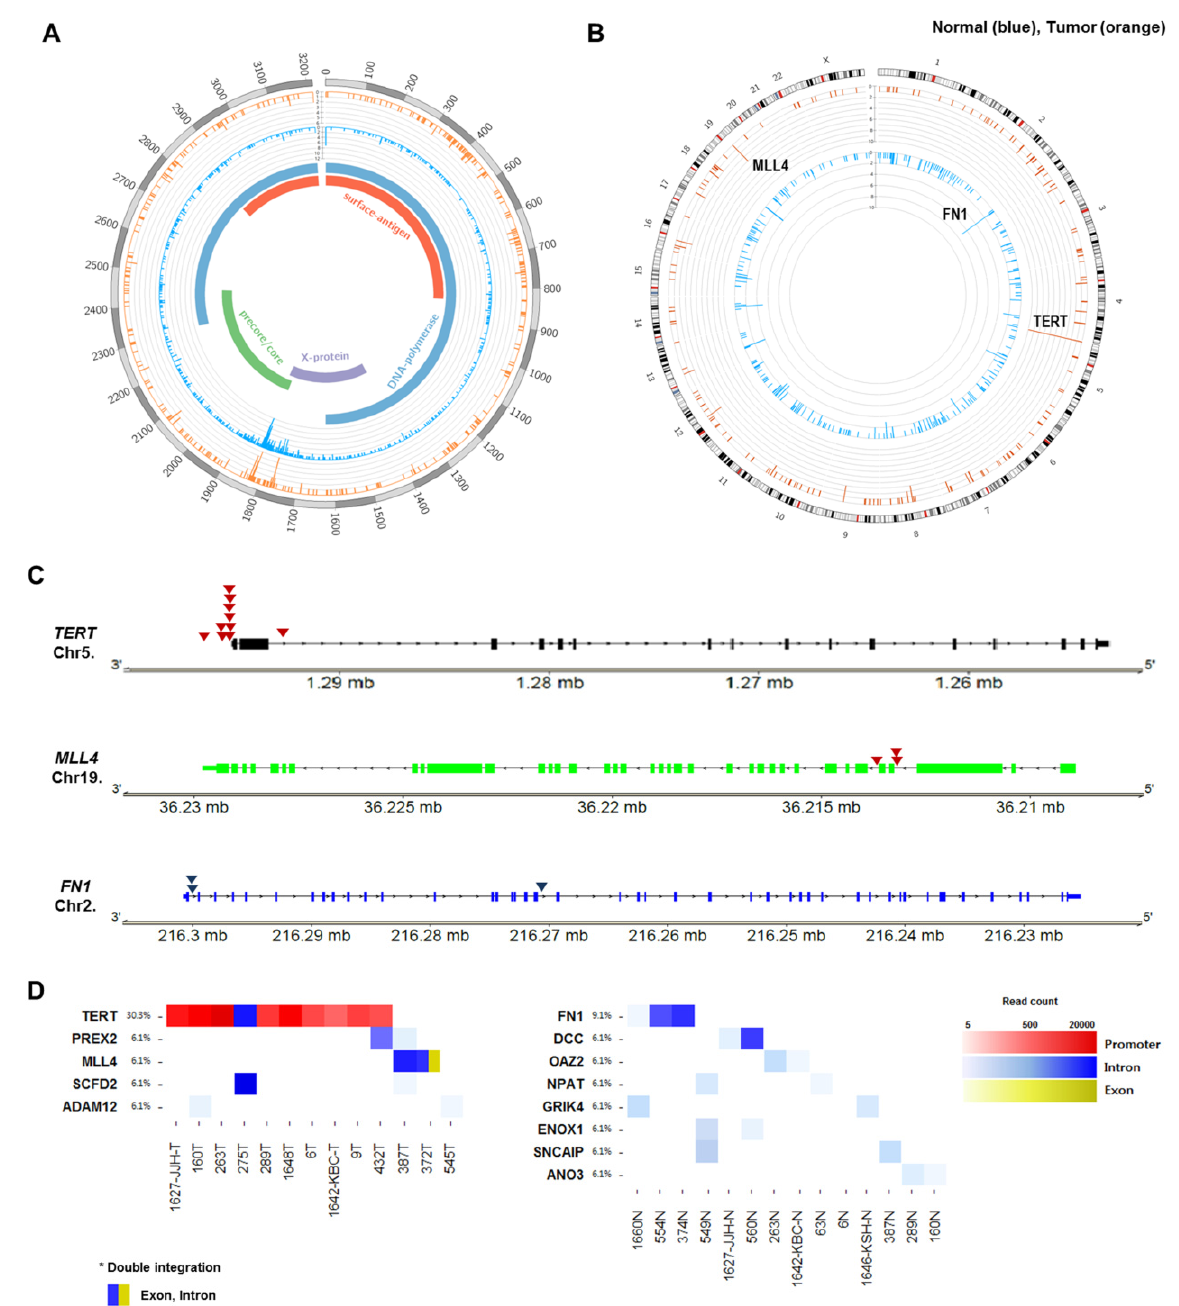
Figure 3. Circos plot showing the distribution of integration sites in the ( A ) HBV genome and ( B ) human genome. Bars in orange and sky blue indicate HBV integration breakpoints in tumor and adjacent non-tumor tissues, respectively. ( C ) The genomic locations of the three high-frequency HBV-integrated genes ( TERT , MLL4 , and FN1 ). ( D ) Intragenic locations of all recurrent target genes of HBV integration in tumors (T) and non-tumor (NT) tissues. TERT , telomerase reverse transcriptase; MLL4 , mixed lineage leukemia 4; FN1 , fibronectin 1; PREX2 , phosphatidylinositol-3,4,5-trisphosphate dependent Rac exchange factor 2; SCFD2 , sec1 family domain containing 2; ADAM12 , ADAM metallopeptidase domain 12; DCC , DCC netrin 1 receptor; OAZ2 , ornithine decarboxylase antizyme 2; NPAT , nuclear protein, coactivator of histone transcription; GRIK4 , glutamate ionotropic receptor kainate type subunit 4; ENOX1 , Ecto-NOX disulfide-thiol exchanger 1; SNCAIP , synuclein alpha interacting protein; ANO3 , anoctamin 3.